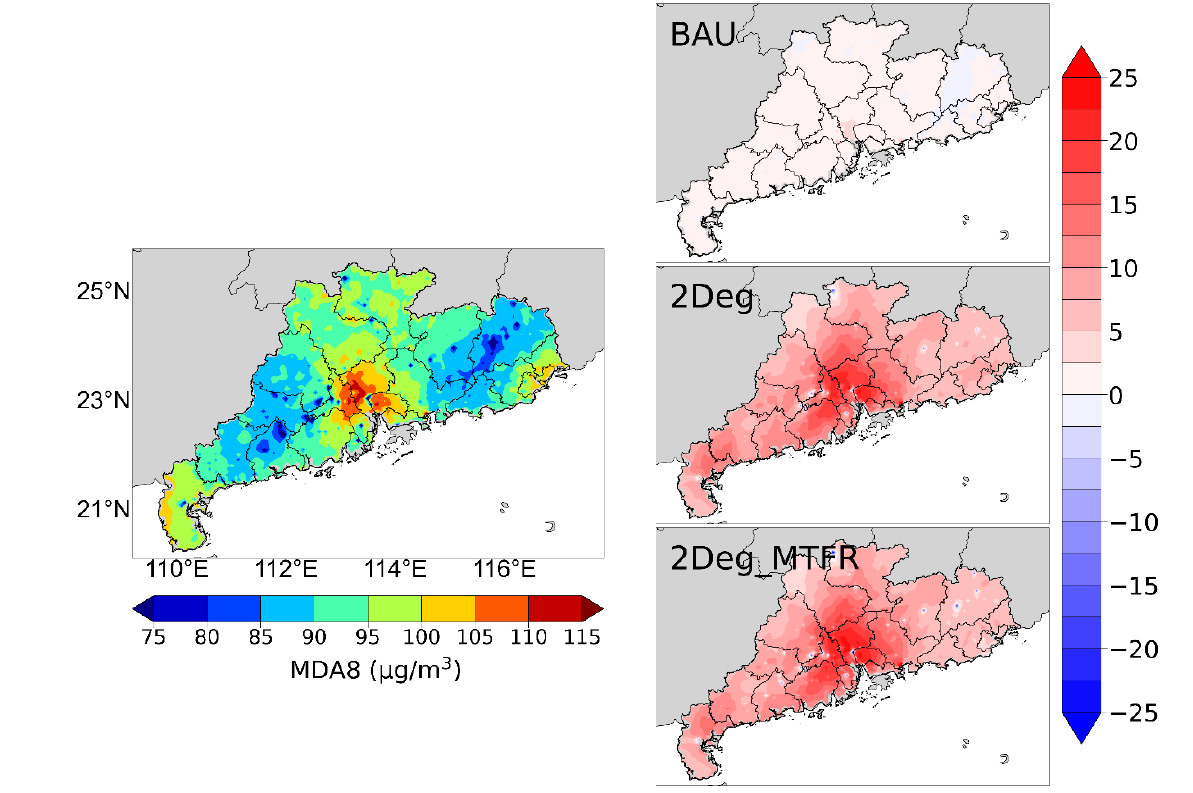
Figure 4. Spatial distribution of MDA8 concentrations in Guangdong in 2015 ( left figure ). The changing MDA8 concentrations under the three scenarios in 2050 ( right figures ), with red representing the decreasing concentrations relative to 2015, and vice versa for blue.